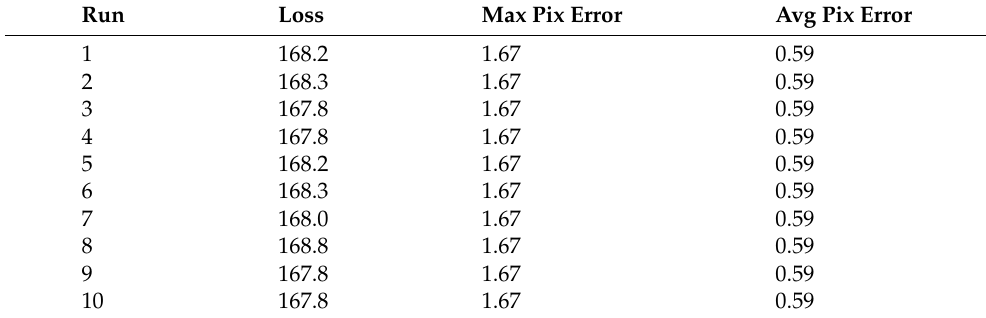
Table 12. CMA-ES real